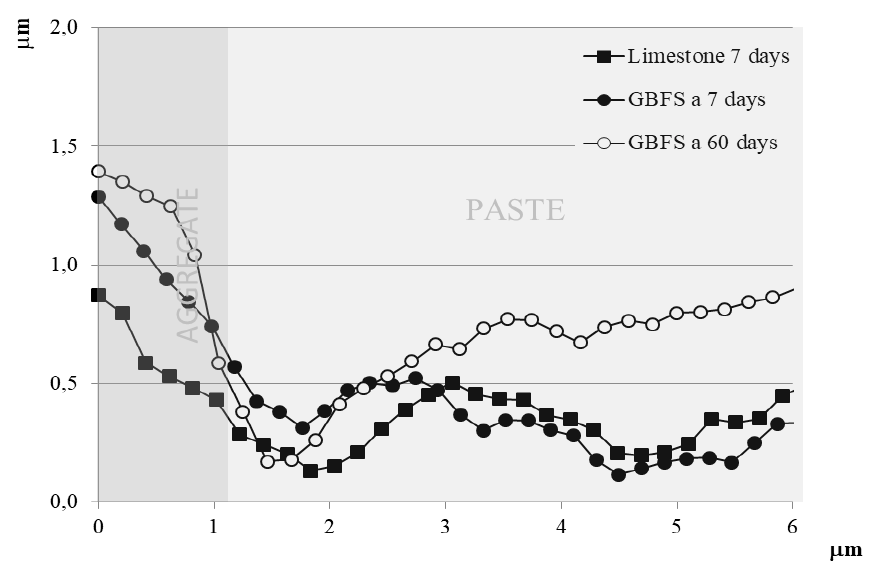
Figure 10. Topographical profile of the interface at 7 and 60 days with atomic force technique.